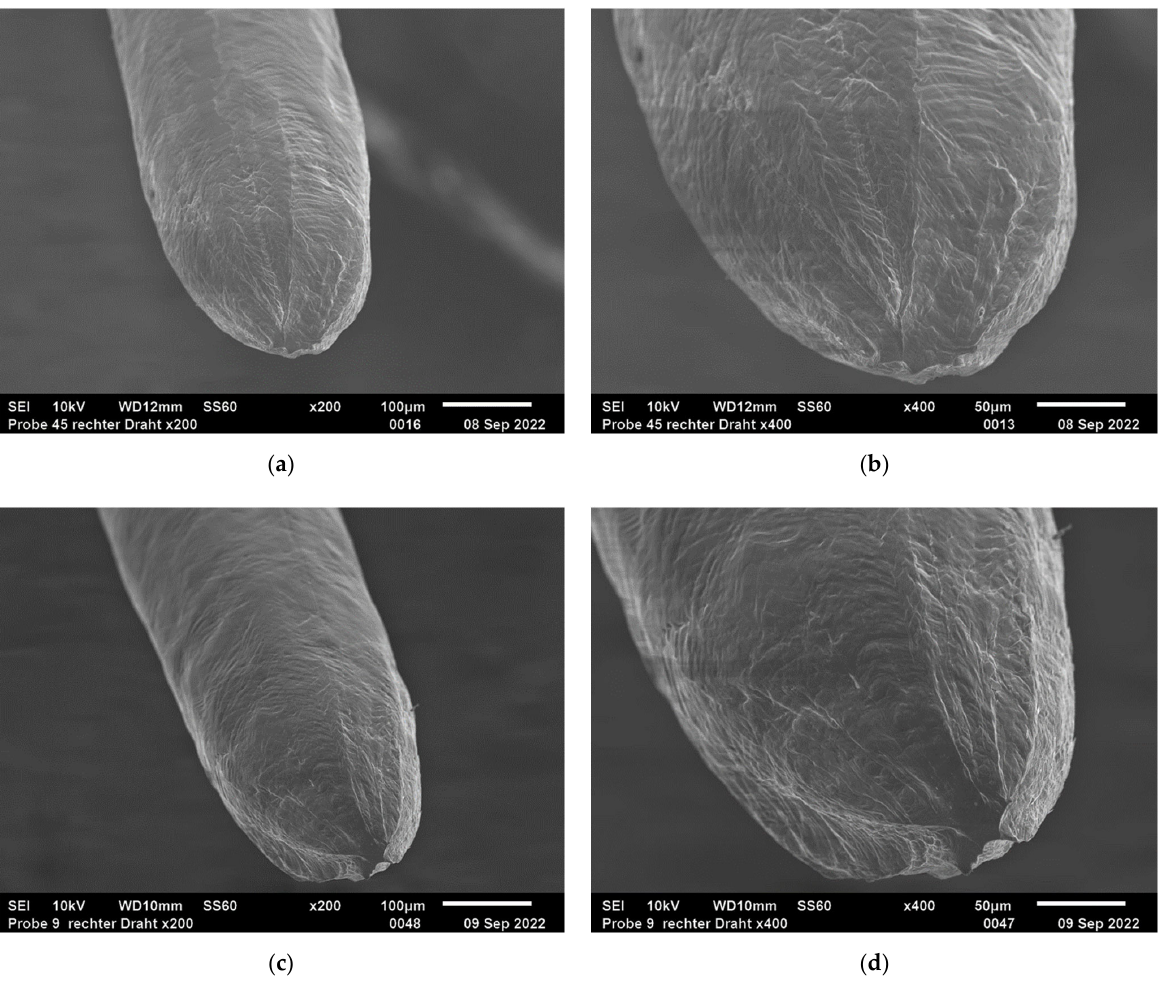
Figure 8. SEM images of Al ‐ Pure at R = 0.1, σ a = 16 MPa, σ max = 35.6 MPa, N = 2,438,255 at magnifications of 200 ( a ) and 400 ( b ) and Al ‐ Prime at R = 0.1, σ a = 17.5 MPa, σ max = 38.9 MPa, N = 4,201,059 at magnifications of 200 ( c ) and 400 ( d ) after fatigue testing.